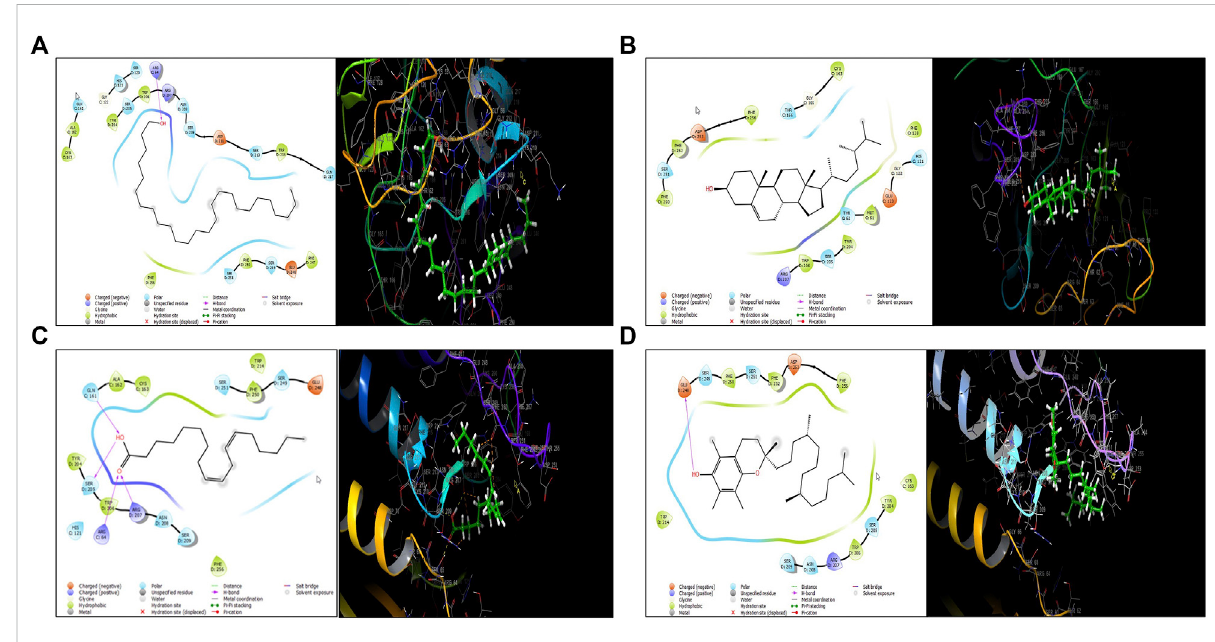
FIGURE 8 Molecular docking of four major polyphenolics to caspase-3. (A) The 2D (left) and 3D (right) diagrams of the 1-Hexacosanol interactions with theactivesiteofcaspase-3(PDB:3GJQ). (B) The2D(left)and3D(right)diagramsofthe9,12-Octadecadienoicacid(Z,Z)-interactionswiththeactive site of caspase-3 (PDB: 3GJQ). (C) The 2D (left) and 3D (right) diagrams of the Campesterol interactions with the active site of caspase-3 (PDB: 3GJQ). (D) The 2D (left) and 3D (right) diagrams of the DL-alpha-Tocopherol interactions with the active site of caspase-3 (PDB: